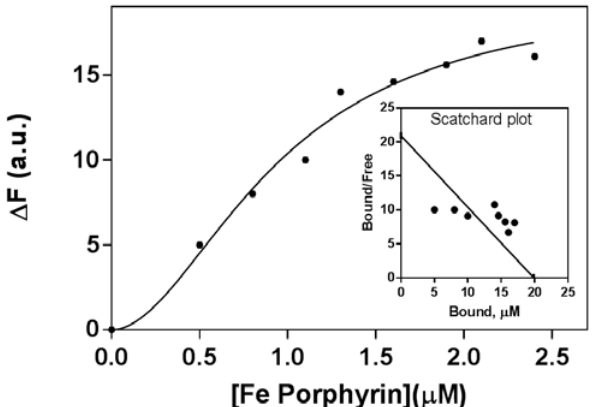
Fig. 3. Representative binding curve, showing the formation of Con A-FeTMPyP complexes K =0.95±0.13 μM (inset- Scatchard plot, D